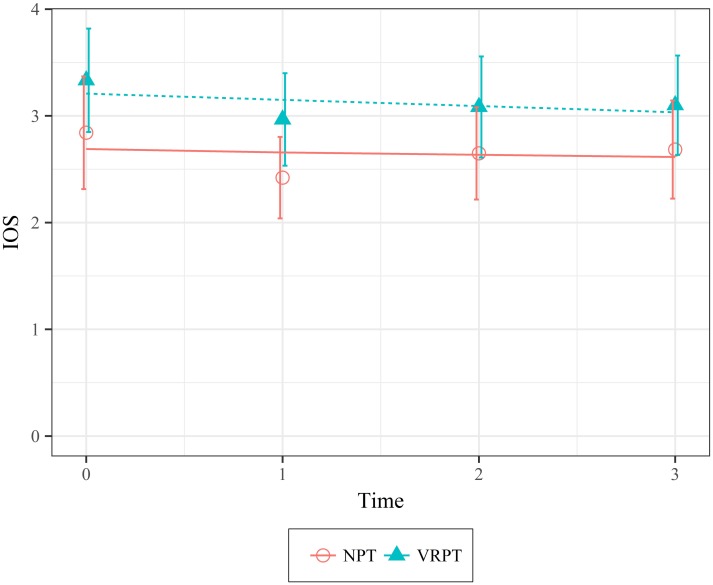
Mean values of self-other overlap with the homeless as a function of condition over time.Higher scores represent higher overlap between the self and the homeless. Error bars represent 95% Confidence Intervals.